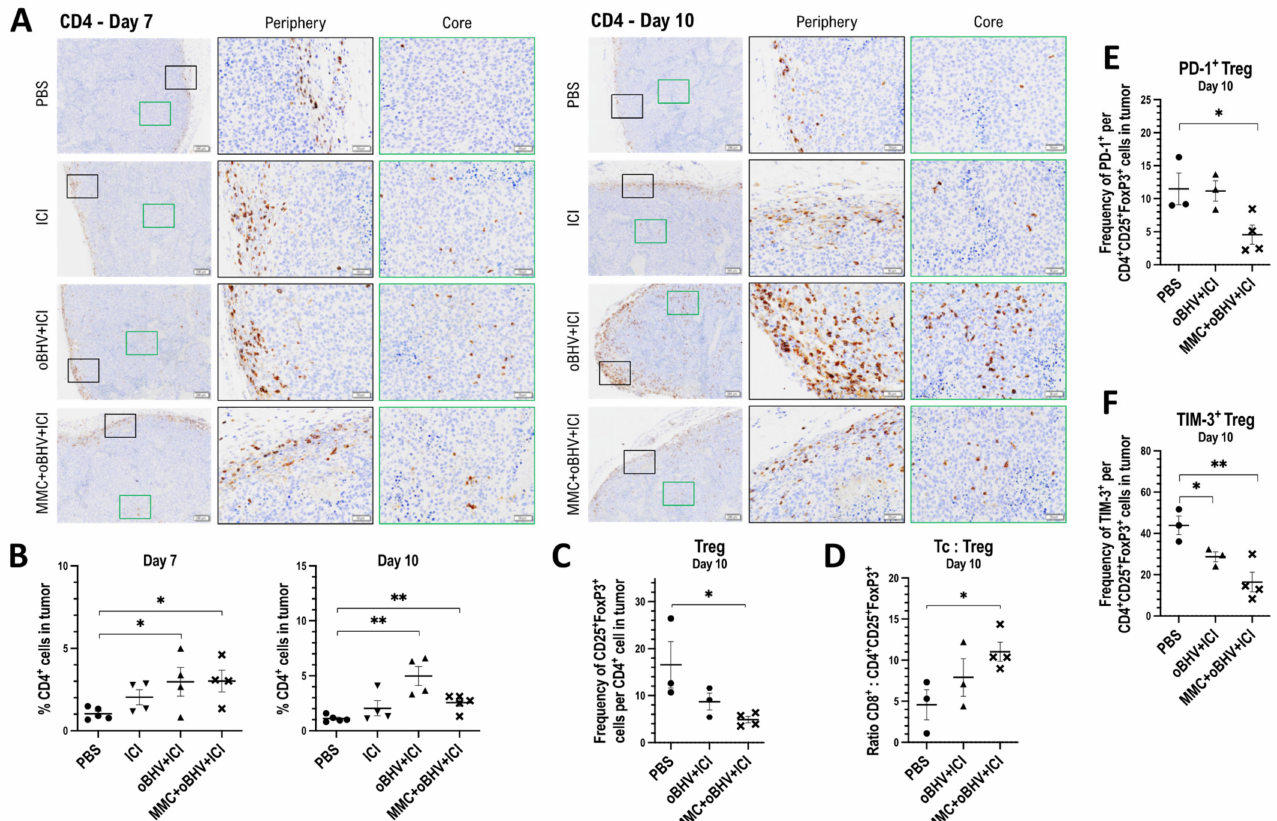
Figure 5. B16-C10 tumors were treated with PBS, ICI, oBHV + ICI or MMC + oBHV + ICI. CD4 IHC was performed on tumors on days 7 and 10 ( A ). Images with 2 × magnification are shown in left panels, and 10 × images of the tumor periphery (black) and core (green) are shown in the center and right panels. Scale bars: 200 µ m ( left panels); 50 µ m ( center and right panels). Quantification of CD4 + cells was performed over the whole tumor area ( B ). In addition, tumors were processed on day 10 and TILs were stained for analysis via flow cytometry to determine Treg TILs ( C ), ratio Tc: Treg ( D ) and level of activation of Treg TILs. * p < 0.05, ** p <